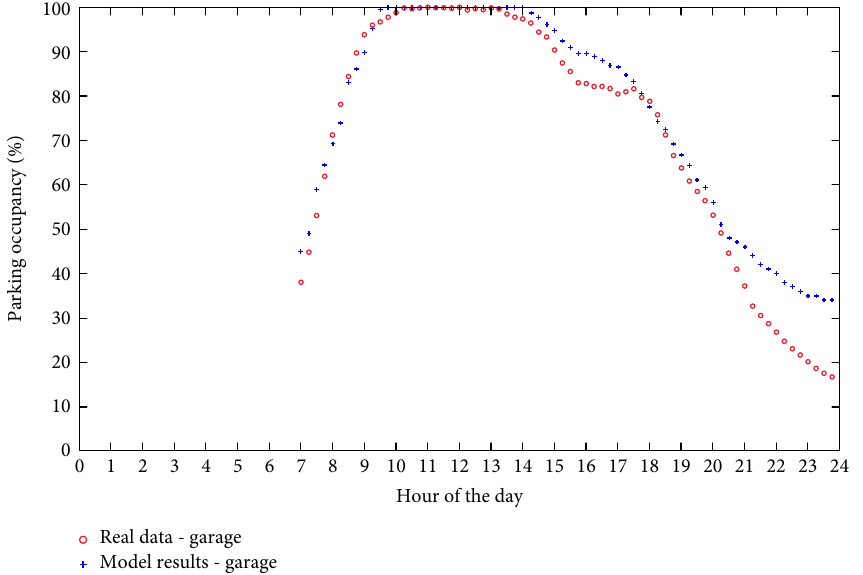
Figure 6: Comparison between the empirical garage and the estimated garage parking occupancy. (Empirical data were collected and averaged over 12 working days from 3 weeks during 1 st –22 nd April,